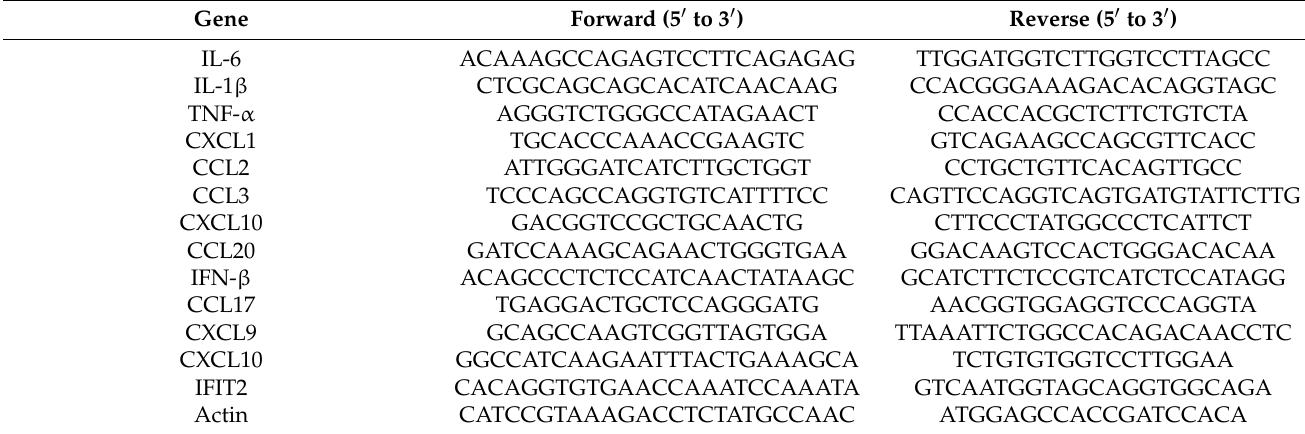
Table 2. Primer sequences of the genes used for quantitative real-time polymerase chain reaction.